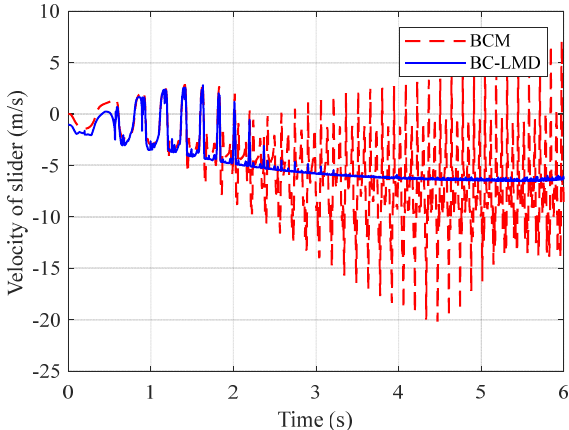
Figure 10. Lower bound of the velocity of the slider.